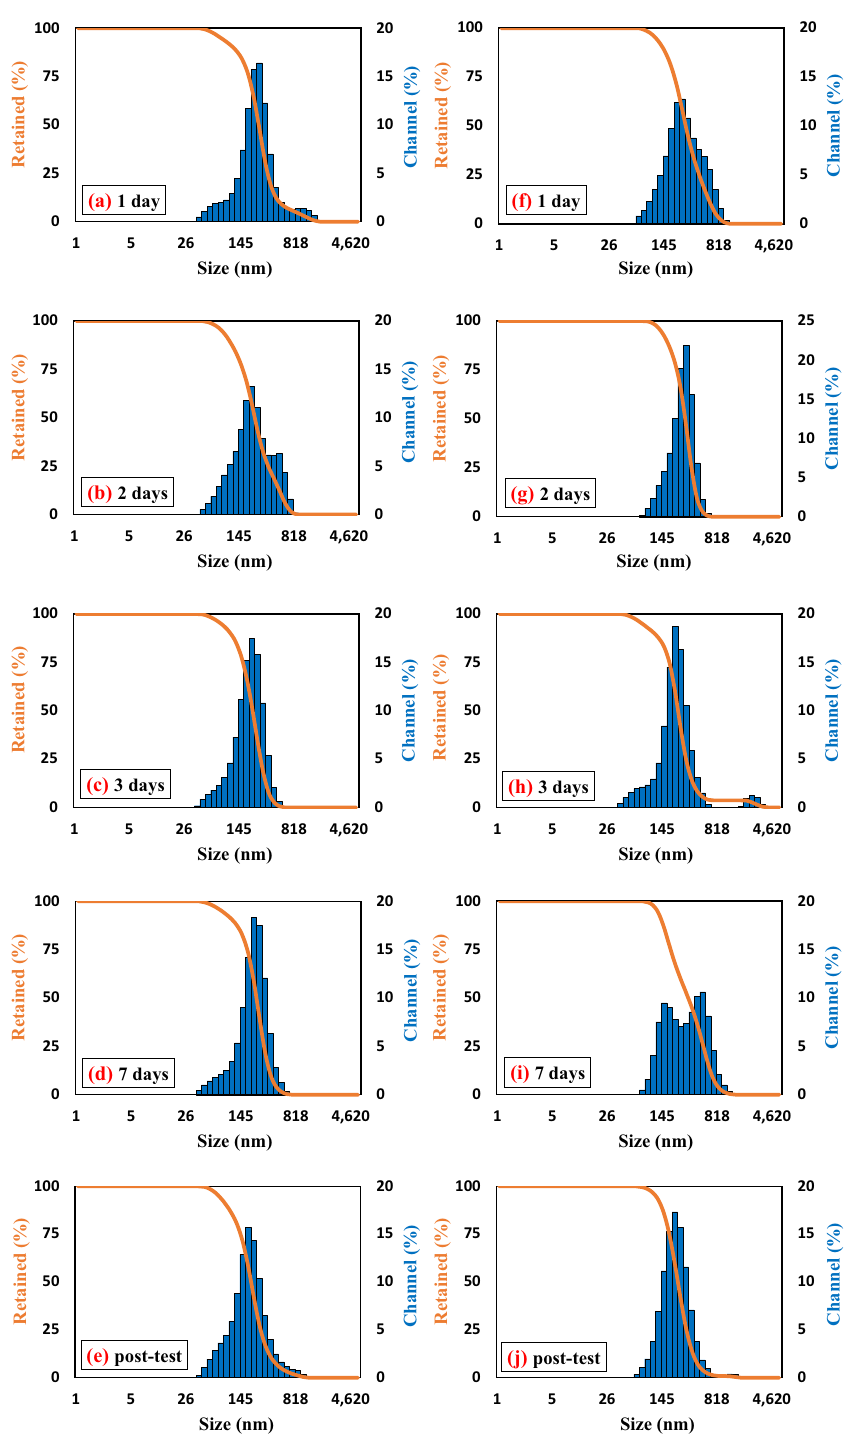
Figure 6. DLS data analysis for the nanofluids post-test and after several days: ( a – e ) MWCNTs, and ( f – j ) TiO 2